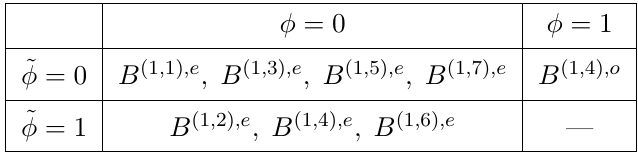
Table 19 . The bi-grading of the generators of the boundary classifying algebras of FM (3 ; 8) (parity (cid:30) ) and g FM (3 ; 8) (parity ~ (cid:30) ), with the identi(cid:12)cation B (1 ;a ) ;u = B (1 ;a ) ;e , B (1 ; 4) ;s = iB (1 ; 4) ;o , cf.